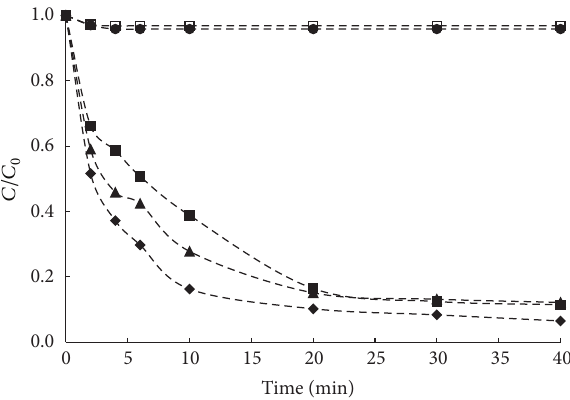
Figure 1: Degradation of 4 × 10 −5 molL −1 AG50 by the Fenton process using 2.85 × 10 −3 molL −1 H 2 O 2 with different iron content (mg/g Fe 2 O 3 ) in 100mg L −1 of catalyst calcined at 500 ∘ C (at pH = 2). ( e ) 0.0, ( ◼ ) 14.4, ( 󳵳 ) 18.1, ( X ) 37.4, and ( ◻ ) 0.0 without H 2 O 2